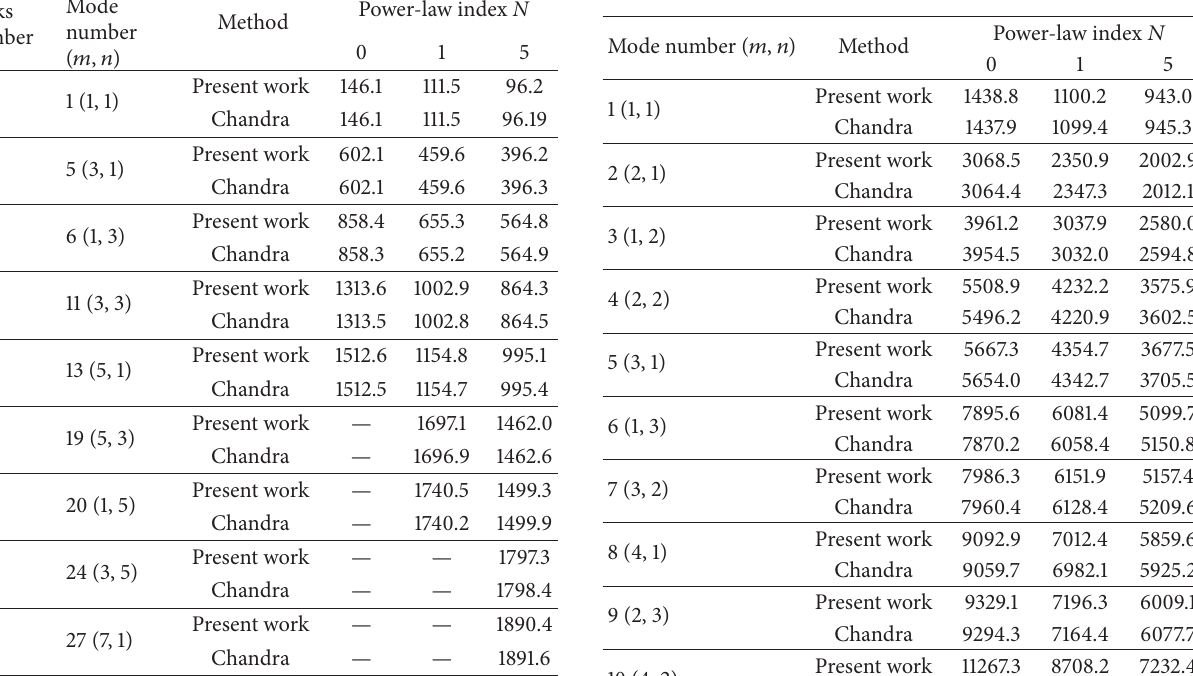
Table 2: The first 10 structural frequencies of the FGM plate with thickness ℎ = 0.03 m: comparison between the present work and Chandra et al.